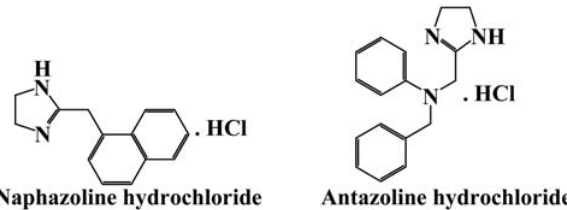
Figure 1. Molecular structures of